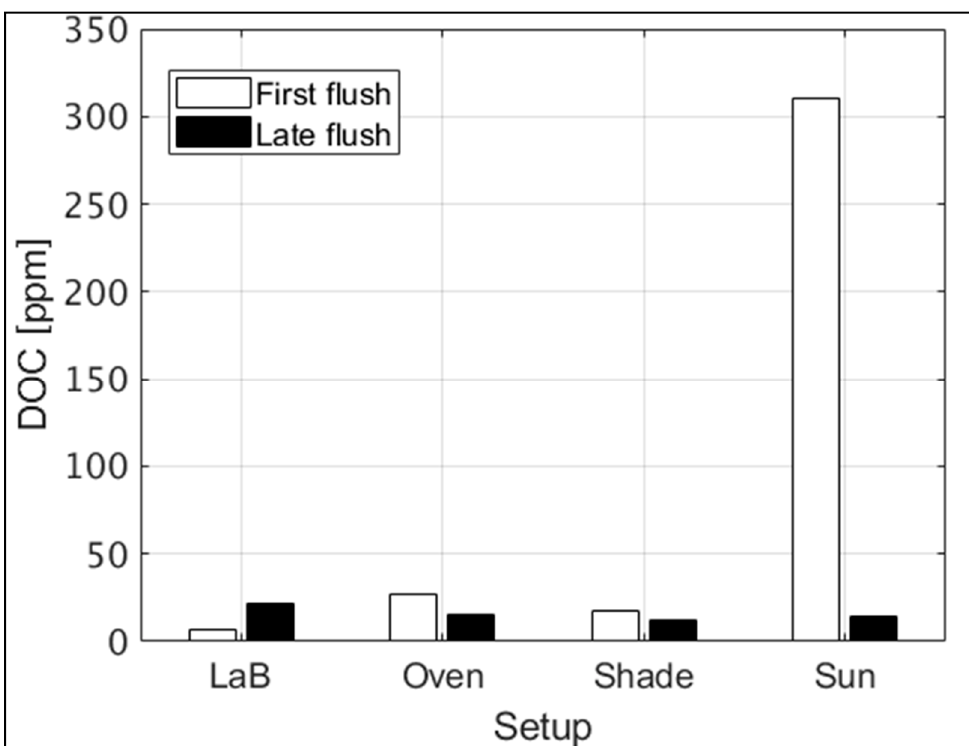
Figure 11. DOC concentrations in drained water from the different BS setups at the beginning of the rain event (first flush) and toward the